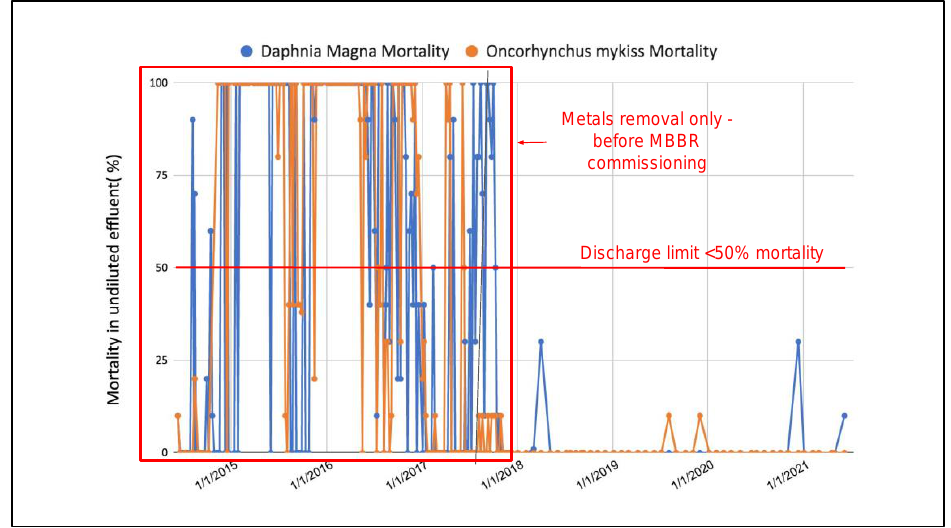
Figure 12. Evolution of the toxicity of the discharge water (to environment) of the full-scale application (before and after the implementation of the two-stage MBBR process).